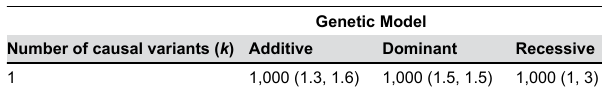
Table 1. Number of cases/controls ( n ), relative risk of heterozygote to non-risk allele homozygote ( R risk of risk allele homozygote to non-risk allele homozygote ( R ) used at each simulation setting under the single causal 2 variant scenario of Experiment II.